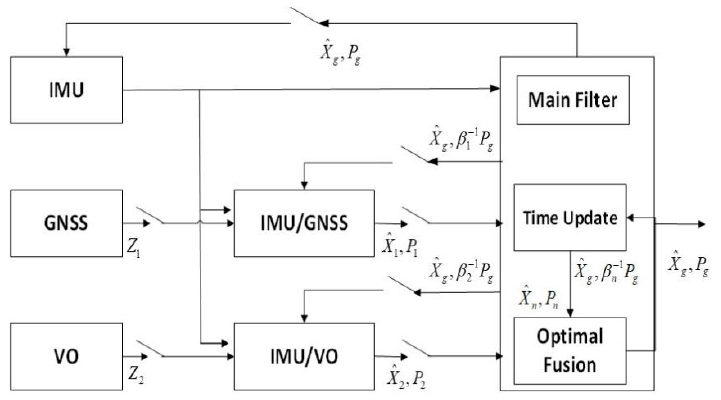
Figure 1. Federated Kalman filter.